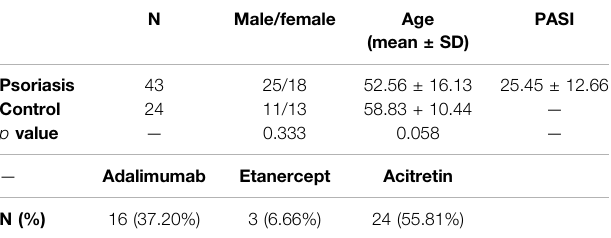
TABLE 1 | The demographics data of psoriasis patients and controls.